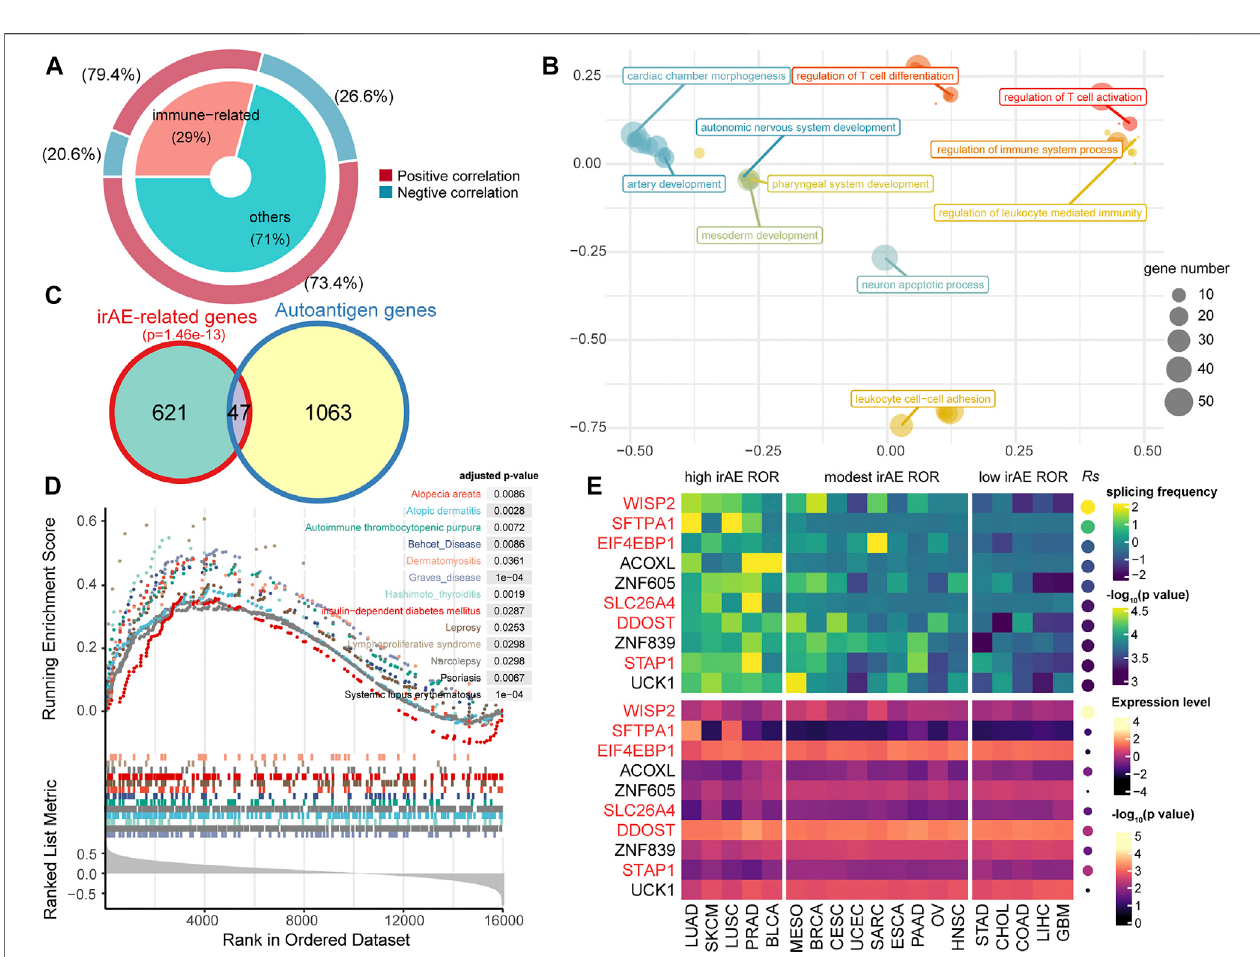
FIGURE 2 | Statistic correlation of splicing frequency and irAE risk across 19 cancer types. (A) Overview of irAE-related genes detected by correlation analysis betweenirAERORandsplicingfrequencyofindividualgene.Thedonutplotprovidesinformationabouttheproportionofimmune-relatedgenesinallirAE-relatedgenes. (B) Functional enrichment analysis for highly positively correlated genes. The scatter plot displays the enriched GO terms. GO term complexity was reduced by measuring semantic similarity using rrvgo. Distances between points represent the similarity between terms. The size of the point represents the number of genes the GO term contains. (C) Venn plot of irAE-related genes and autoantigen genes. The p value of the hypergeometric test is delineated at the top. (D) Gene set enrichment analysis (GSEA) using the autoimmune disease gene sets from GAAD. The input to GSEA pre-ranked module was a ranked list of genes determined by Rs across all genes. (E) Splicing frequency and expression abundance of the top ten genes signi fi cantly correlated with irAE ROR across multiple cancer types. The genes involved in immune response processes were highlighted in red color. Columns represent cancer types. The leftmost panel corresponds to cancer types with high irAE ROR, the middle panel to cancer types with modest irAE risk, and the right panel to cancer types with low irAE ROR. The top panel indicates the splicing frequency of genes. Rows are sorted according to Rs . Rs was calculated from the correlation analysis between the splicing frequency of genes and irAE ROR. The bottom panel shows the expression abundance of each gene, in which Rs was calculated from the expression level of each gene and irAE ROR.